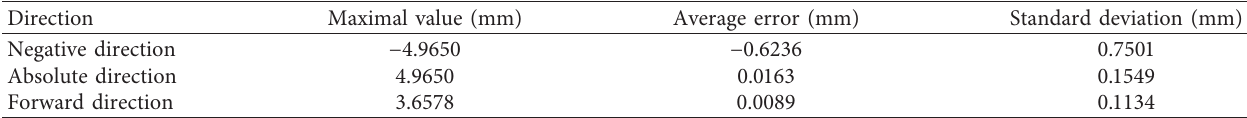
Figure 13: 3D point cloud of the depth map with reflection coefficient from 0.40 to 0.50: (a) traditional phase-shifted method; (b) our Table 2: Evaluation and analysis of the point cloud by the traditional phase-shifted method for Figure 13.